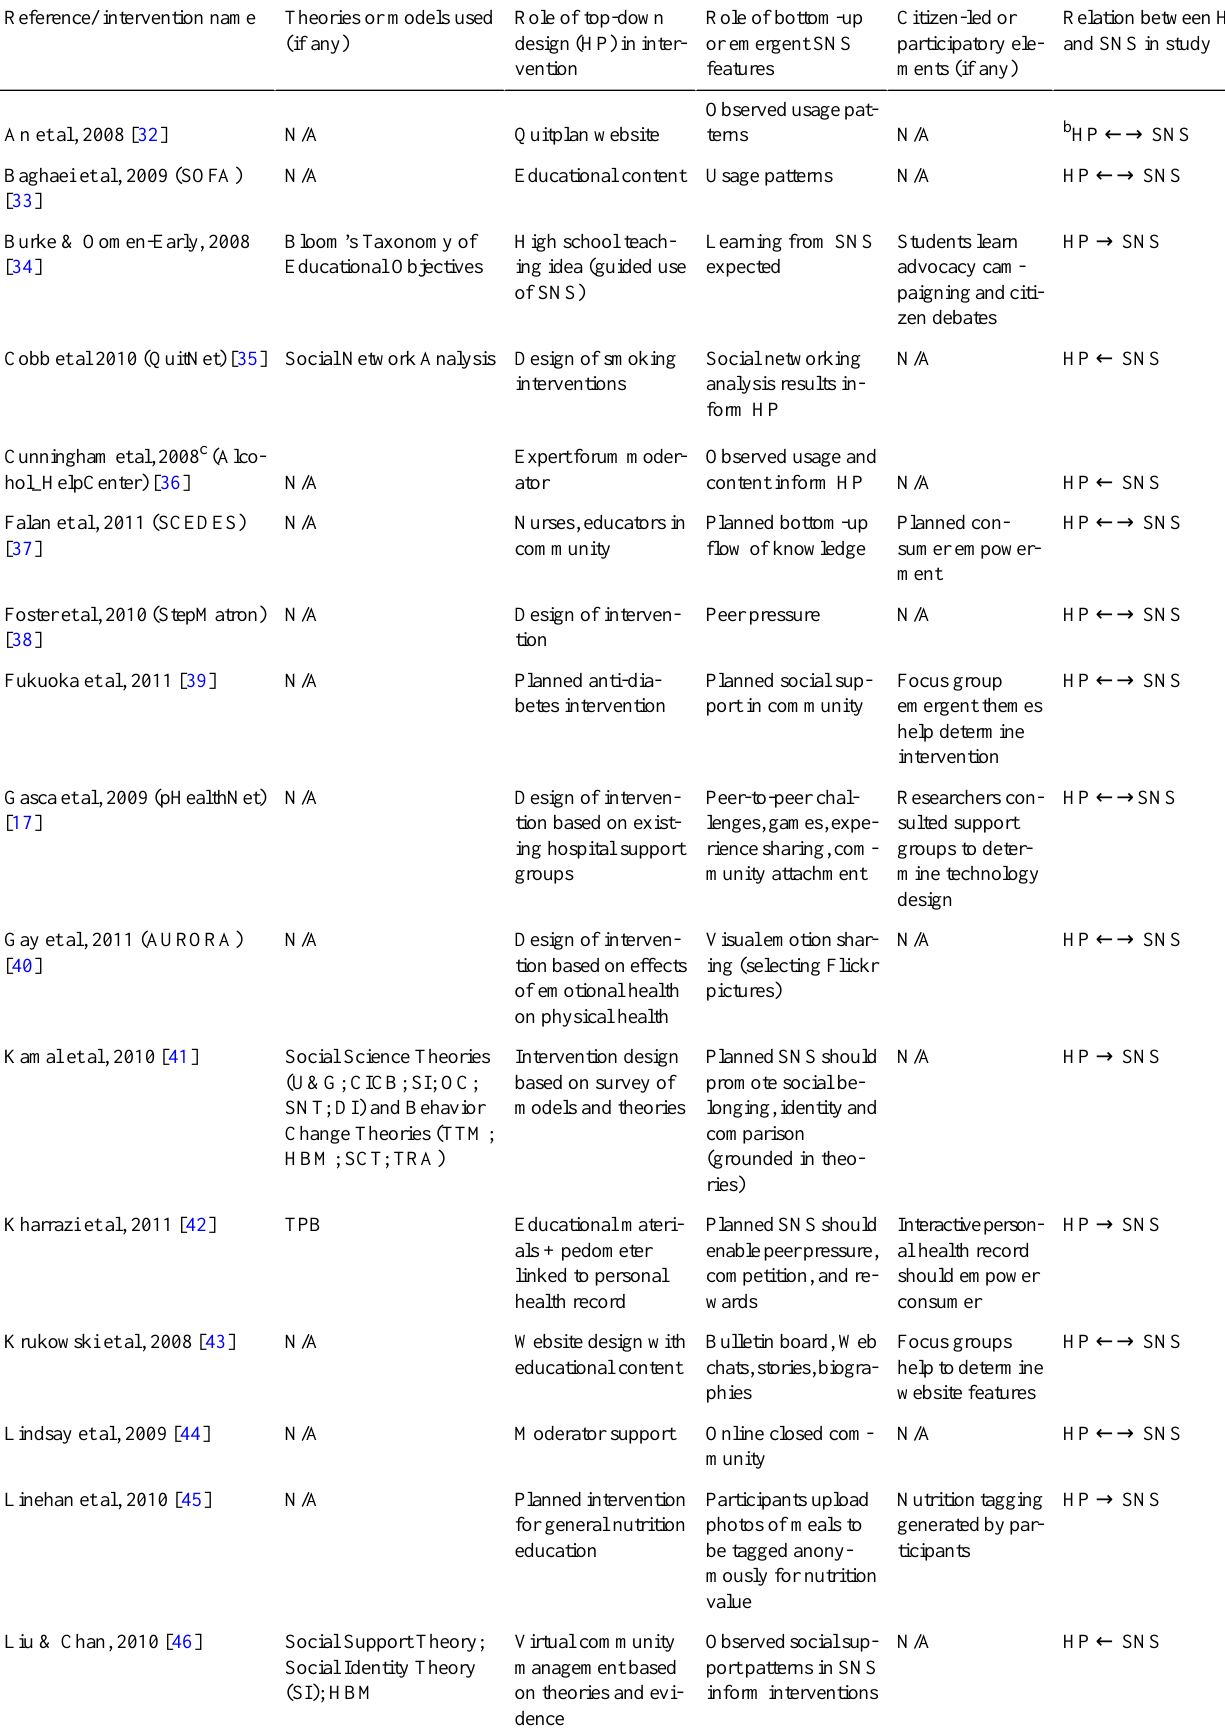
Table 2. Role of theory and relationship between top-down and bottom-up features in interventions. a